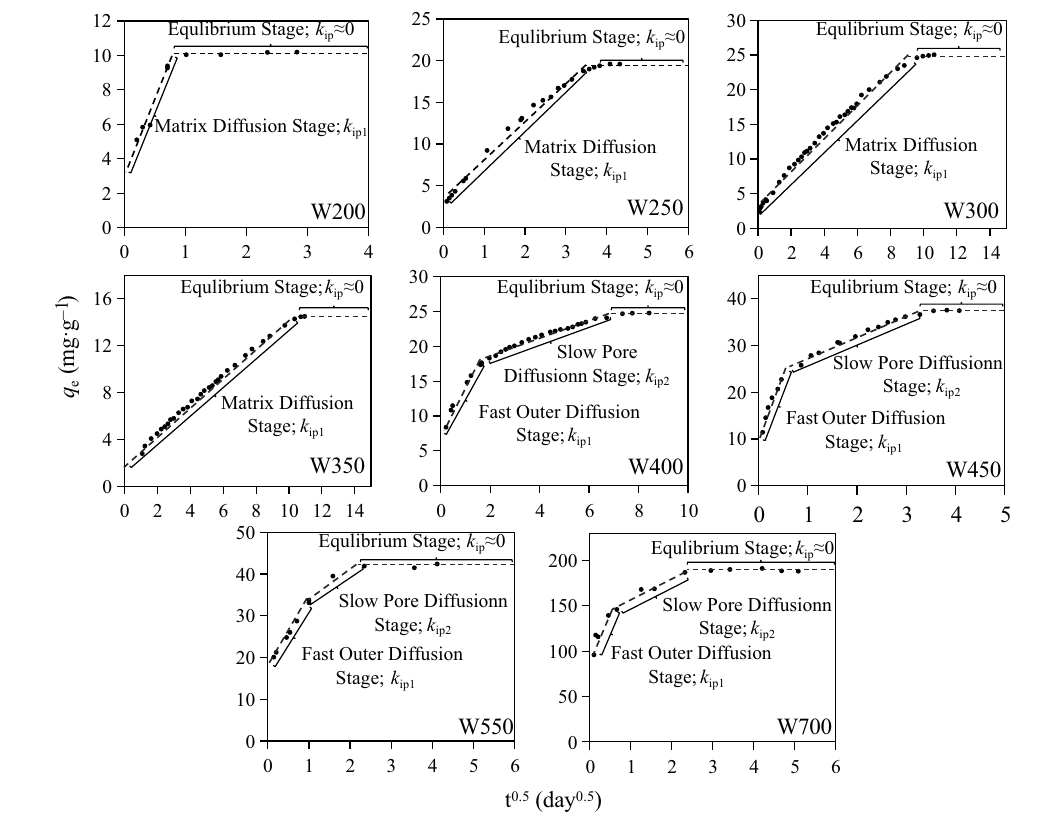
Fig. 1 Sorption kinetic curves and W-M model fittings of 1,3,5-trinitrobenzene on biochars Table 3 Sorption kinetic parameters of 1,3,5-trinitrobenzene on biochars Biochar Pseudo-first-order Pseudo-second-order W-M intra-particle diffusion model -1 q e (mg·g